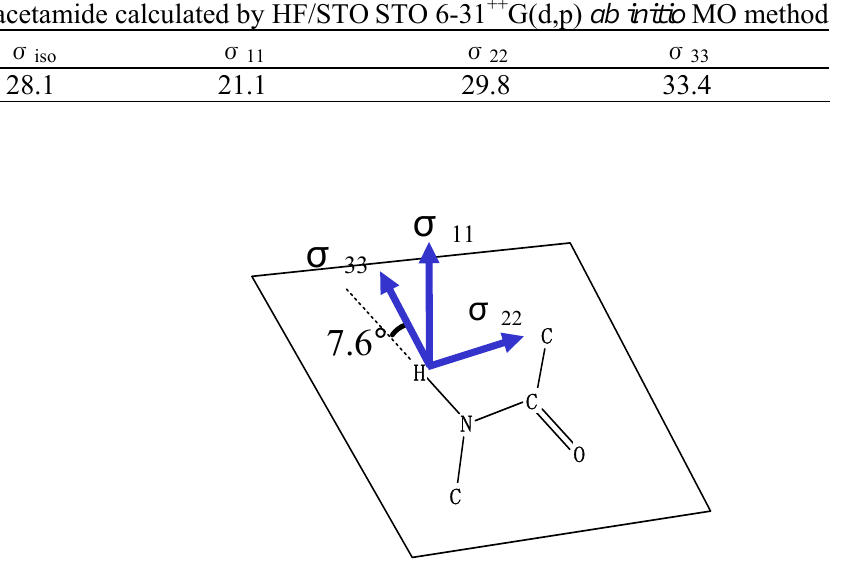
Figure 2. The directions of the chemical shift tensor components σ bonded amide proton are shown together with chemical structure of an N-methylacetamide